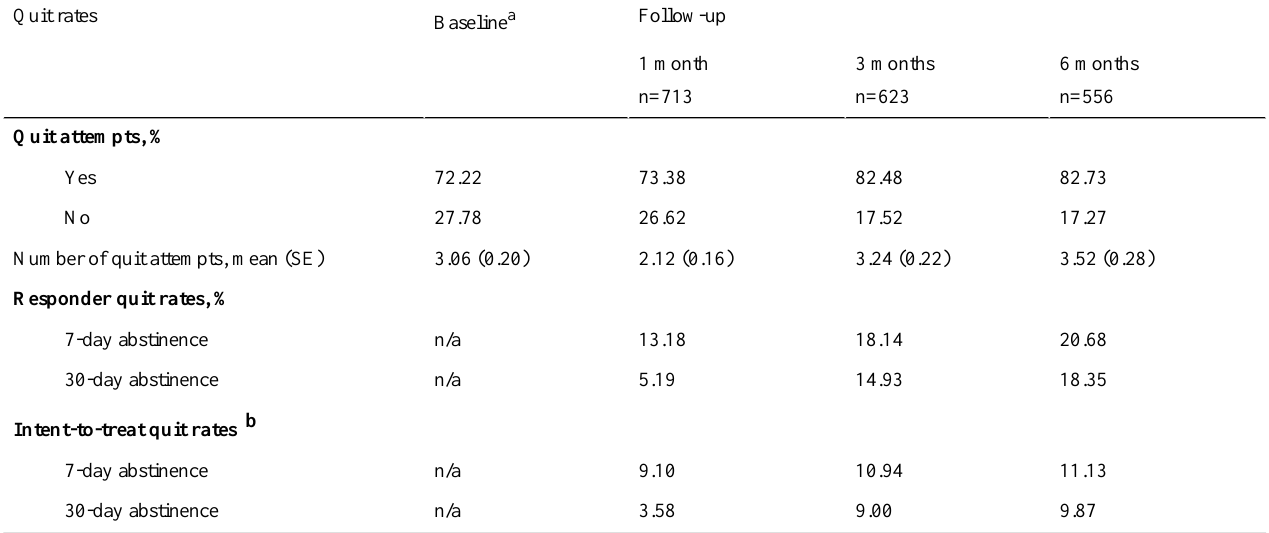
Table 2. Smoking behavior of survey responders over the course of the study